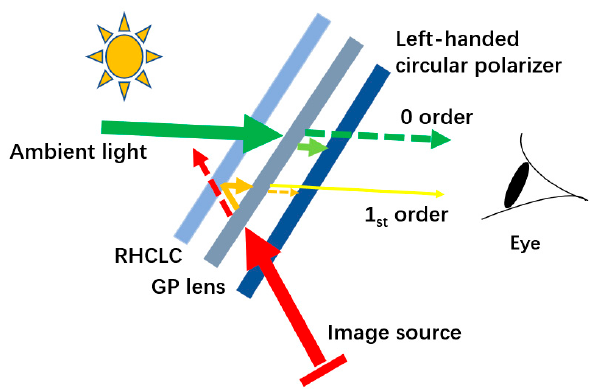
Figure 3. System design of the proposed augmented reality display.